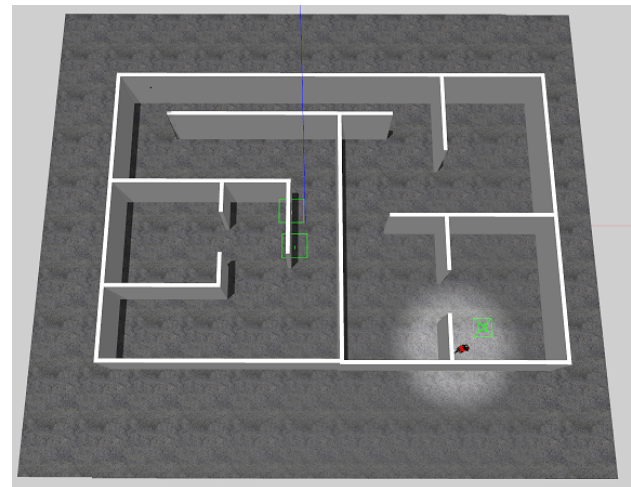
Figure 11. Simulated